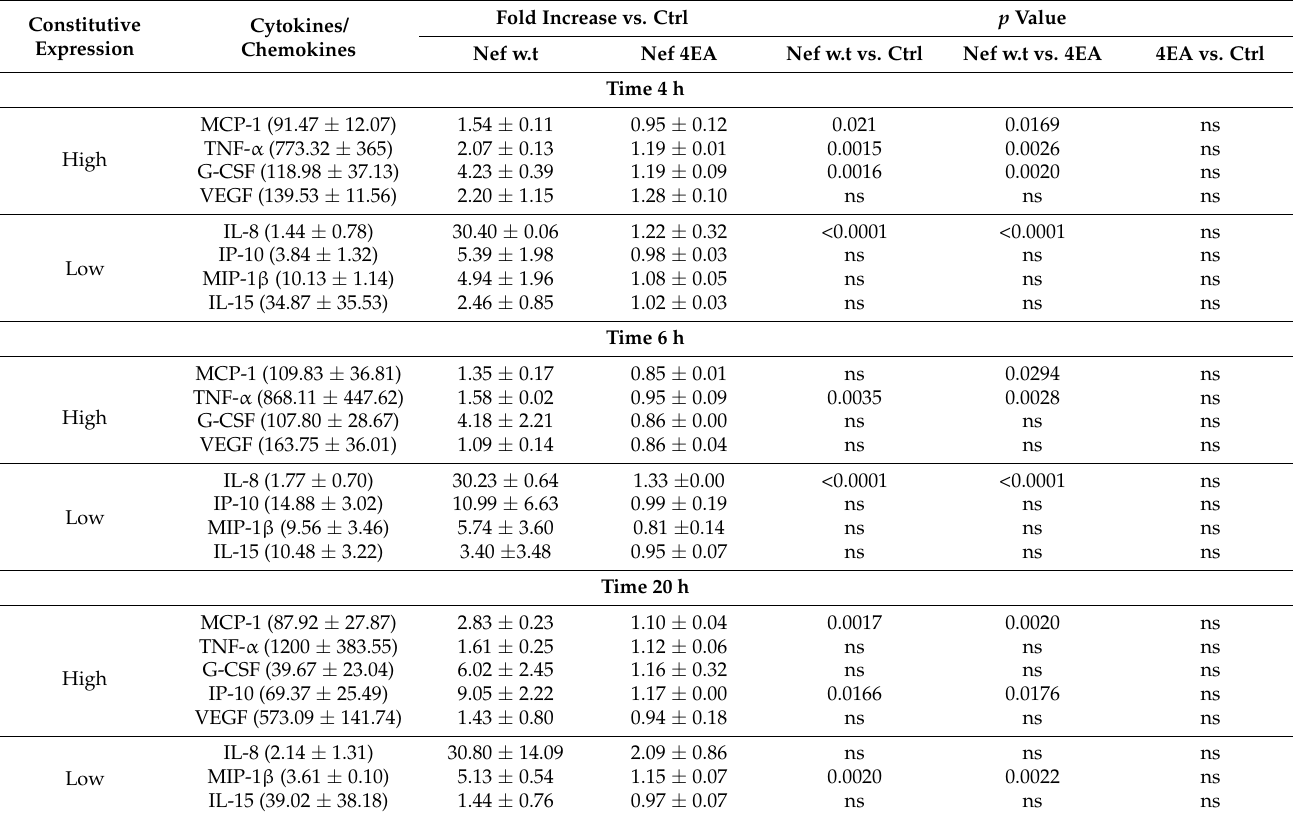
Table 1. Cytokines/chemokines released by GEN2.2 cells in response to